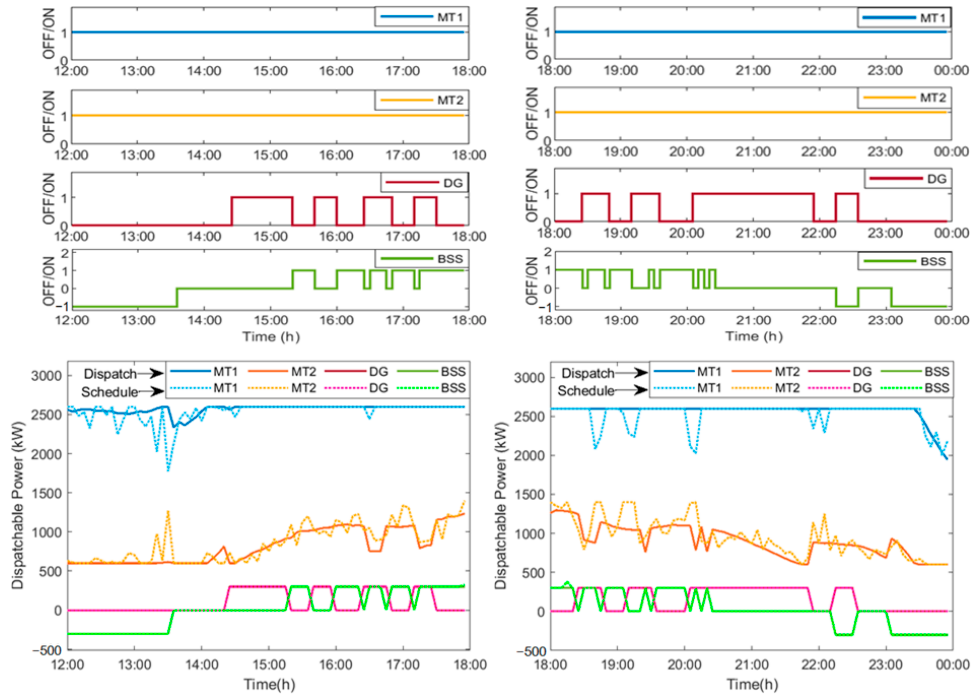
Figure 6. Simulation outcome for 34-bus system from Quarters ‘3’ (Q3, left ) and ‘4’ (Q4, right ): ( top ) control states of DER units; ( bottom ) dispatched power of DER units.